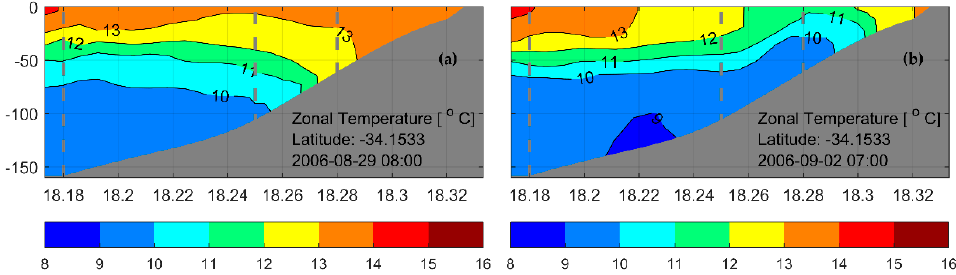
Figure 17. Vertical temperature structure along a zonal transect from Slangkop following onshore (south-westerly) winds ( a ), and again nearly 4 days later after upwelling favourable winds have begun, with upwelling starting to develop ( b ). These sections correspond in time to the event shown in Figure 15. Dashed grey lines indicate profiles corresponding to Hovmöller diagrams available in supplementary material.